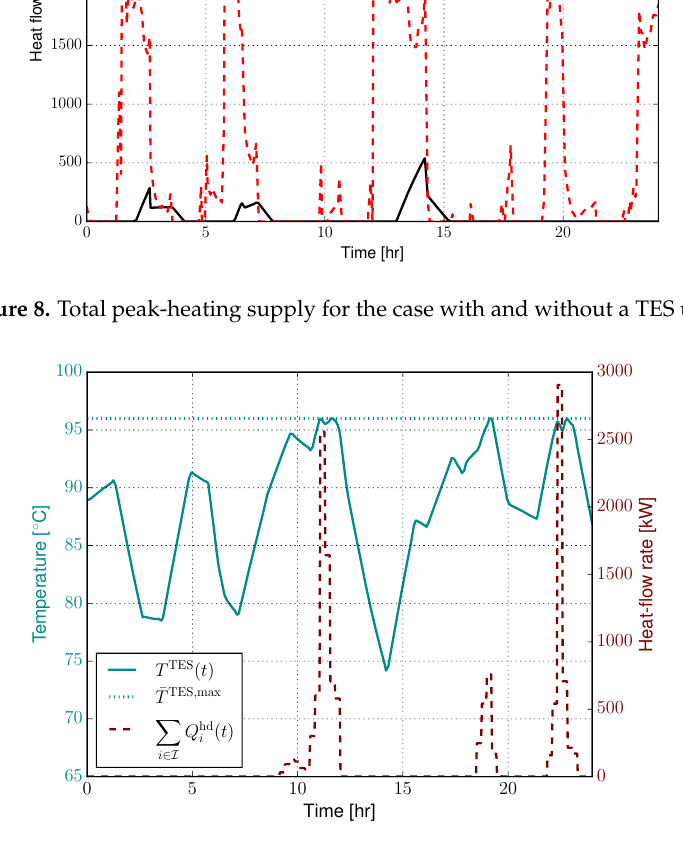
Figure 9. Temperature T TES ( t ) in hot water tank (TES unit) and total dumped heat-flow rate for the case in Figure 3 with TES